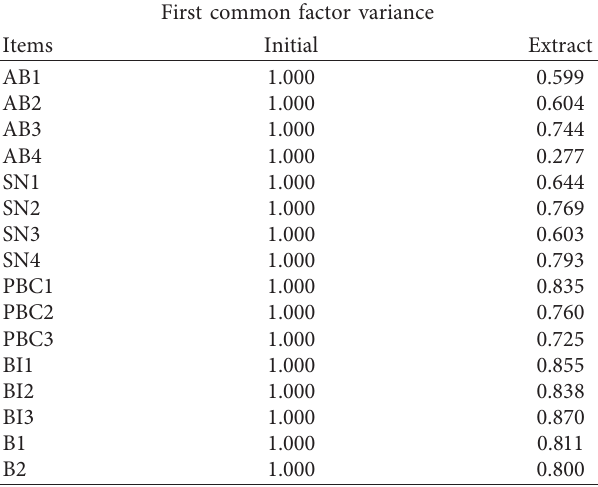
Table 8: First solution to factor analysis.